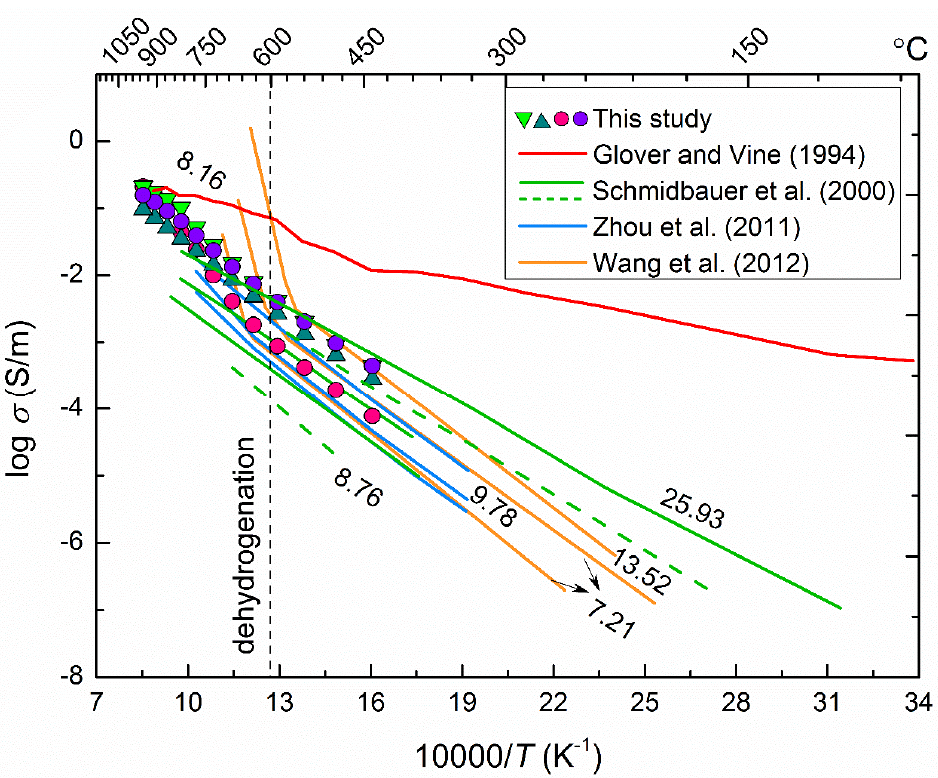
Figure 8. Comparisons between the acquired electrical conductivity of Fe-bearing hydrous amphibole electrical conductivity of amphibole and four previous high-pressure electrical conductivity data for iron-bearing amphibole from Glover and Vine (1994) [118]; Schmidbauer et al. (2000) [116]; Zhou et al. (2011) [119]; and Wang et al. (2012) [120]. The numbers represent the weight percentage (wt %) total ferrous and ferric iron in amphibole (reproduced with permission from the reference of Hu et al. [34]; published by Elsevier, 2018).